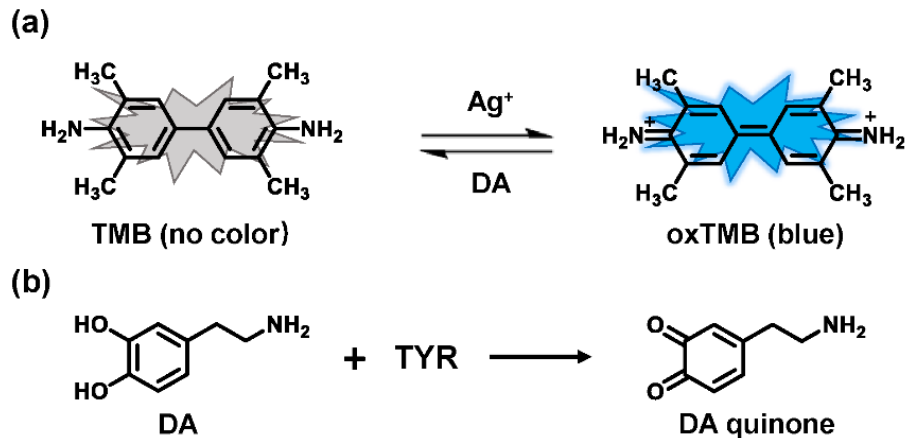
Figure 6. Detection system of Ag + -TMB with dopamine as substrate. ( a ) Mechanism of the colori- metric assay based on Ag + -TMB system for TYR activity. ( b ) The metabolic reaction of dopamine catalyzed by TYR.